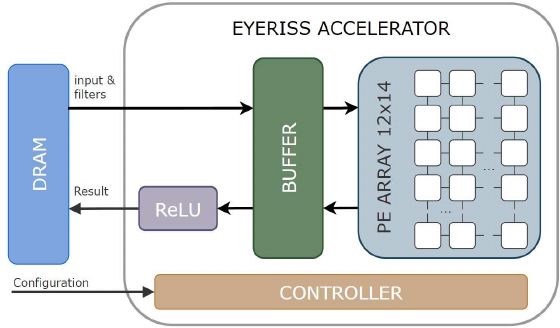
Figure 7. Eyeriss accelerator